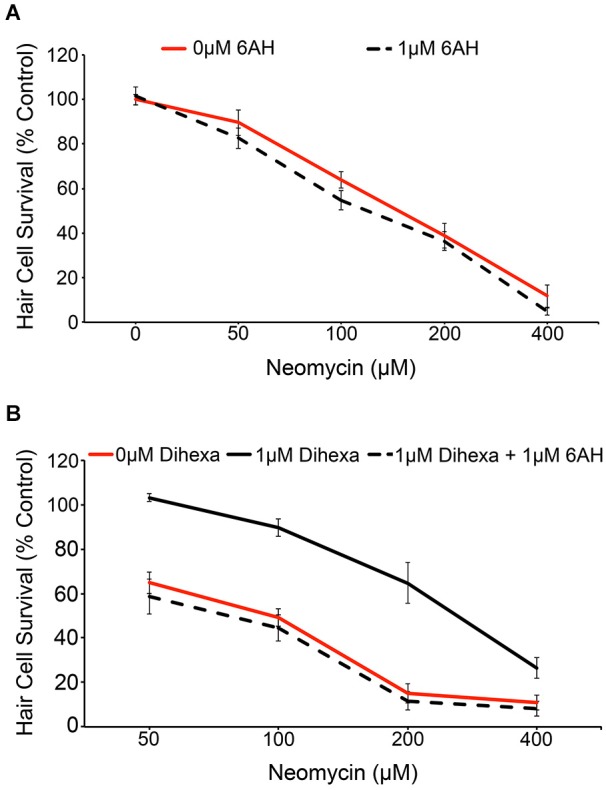
Dihexa-mediated protection is inhibited by the HGF antagonist 6-AH. (A) Treatment with 1 μM 6-AH does not alter lateral line hair cell survival in response to neomycin (Two-way ANOVA; 6-AH: F(1,72) = 3.255 p = 0.0754). (B) Treatment with 1 μM Dihexa decreases neomycin-induced hair cell death over multiple concentrations of neomycin. Co-treatment with 6-AH completely attenuates Dihexa-mediated protection (Two-way ANOVA; Dihexa: F(2,76) = 76.30 p < 0.001). There is a significant difference (p < 0.001) when comparing 1 μM Dihexa vs. 1 μM Dihexa plus 1 μM 6-AH at 50, 100, and 200 μM neomycin treatment groups, p < 0.05 at 400 μM neomycin. N = 6–9 animals per treatment, error bars represent ± s.e.m.